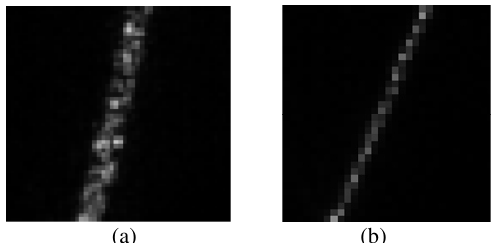
Figure 5. Laser line image with (a) obvious speckle noise and (b) reduced speckle noise on a thinner line